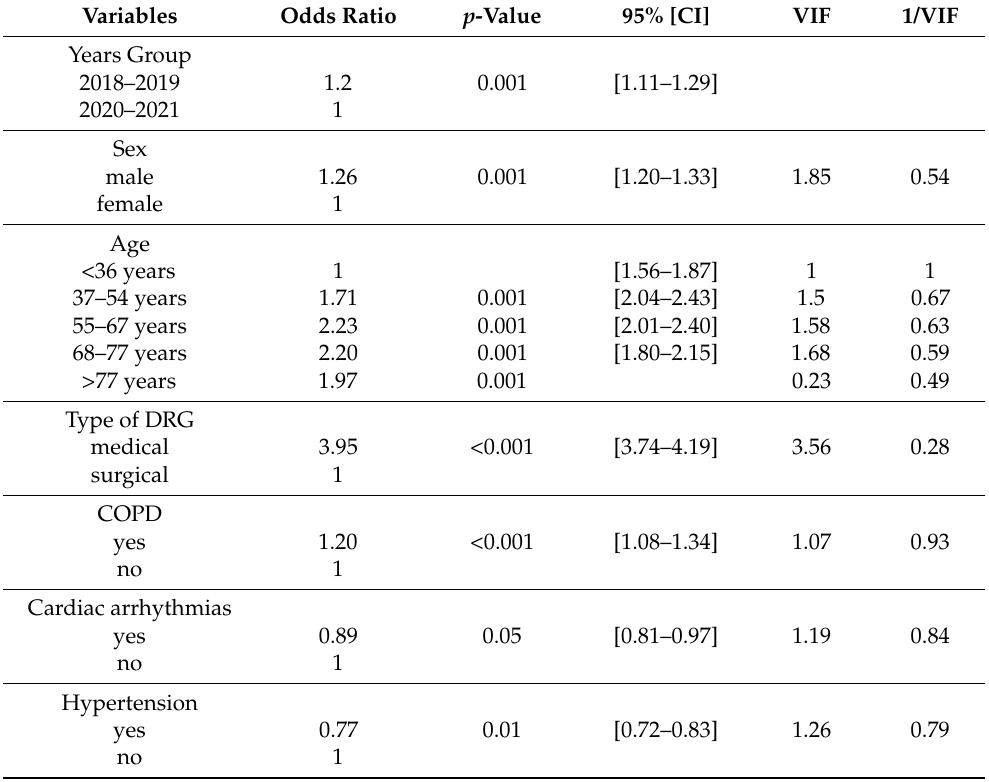
Table 3. Multivariate logistic regression